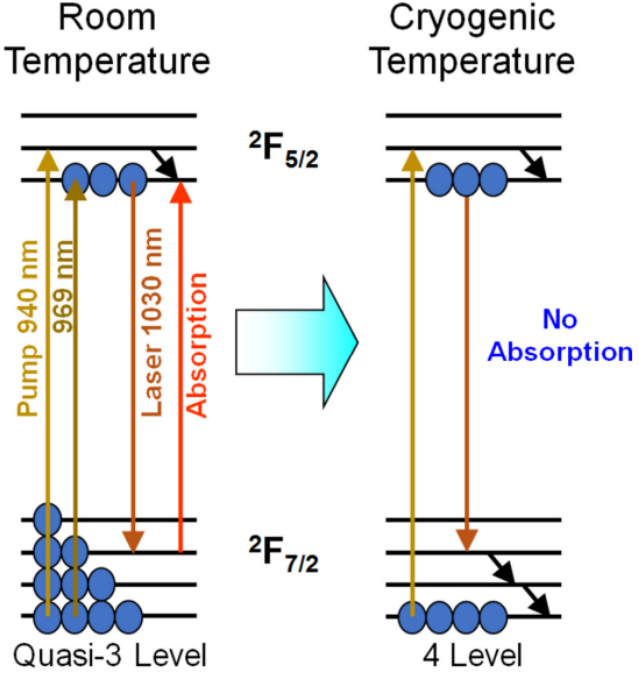
Figure 4. Thermal conductivity, thermo-optic coefficient, and thermal expansion coefficient of YAG crystal as a function of temperature.